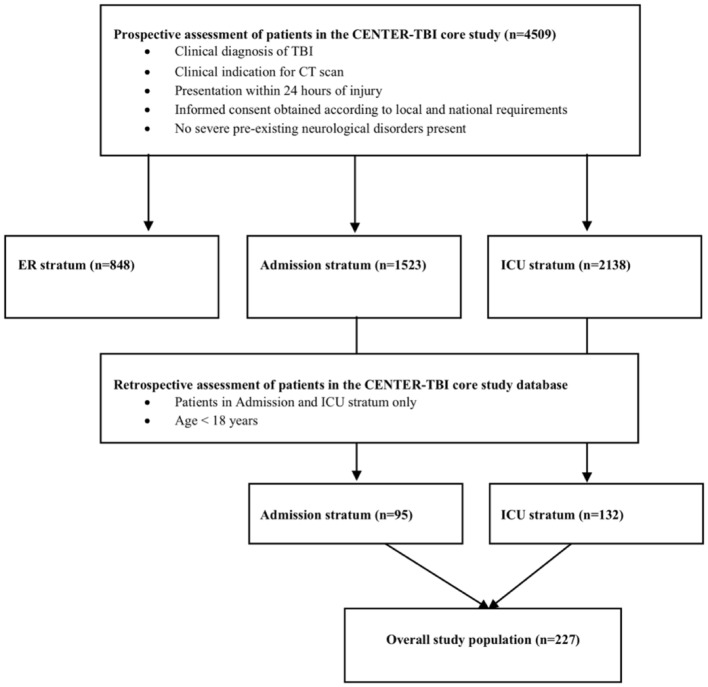
Flow-Diagram of patient selection within the CENTER-TBI core study (separate from the CENTER-TBI registry).